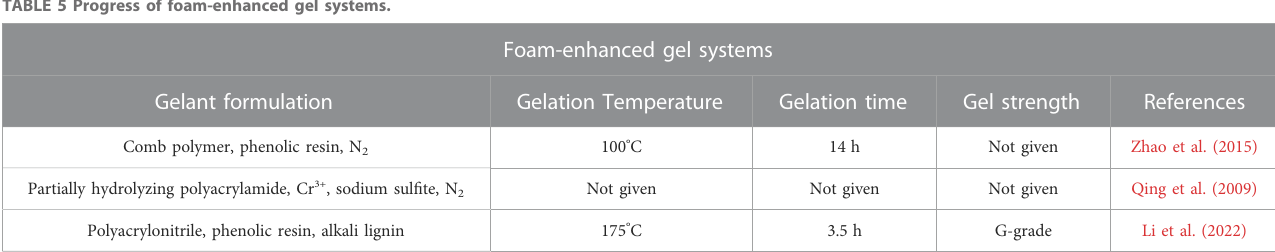
TABLE 5 Progress of foam-enhanced gel systems.